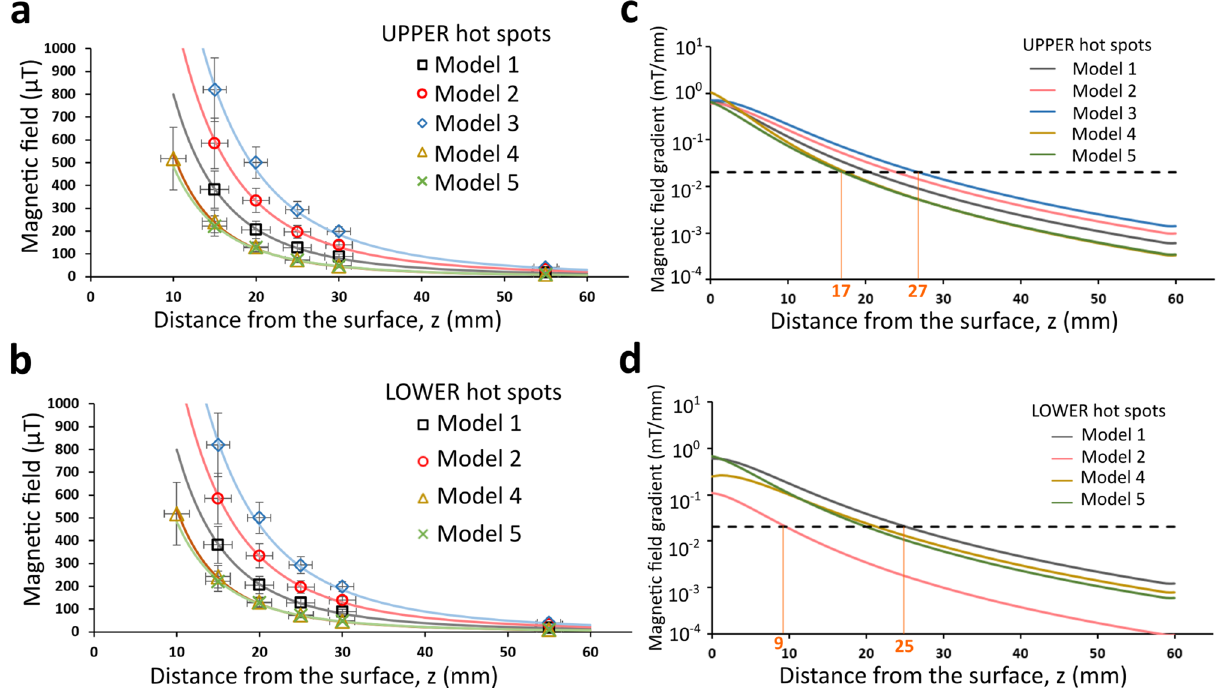
Figure 3. The decay of the field with distance, at the ( a ) upper and ( b ) lower hot spots. Error bars are ± U c , the combined uncertainty (see “Methods” for details). Regression curves are according to our SLC-model, which allowed us to calculate the SMF gradients, ( c , d ). The dashed line in ( c ) and ( d ) is at 0.02 mT/mm, a threshold of interest reported in the literature (see “Discussion and